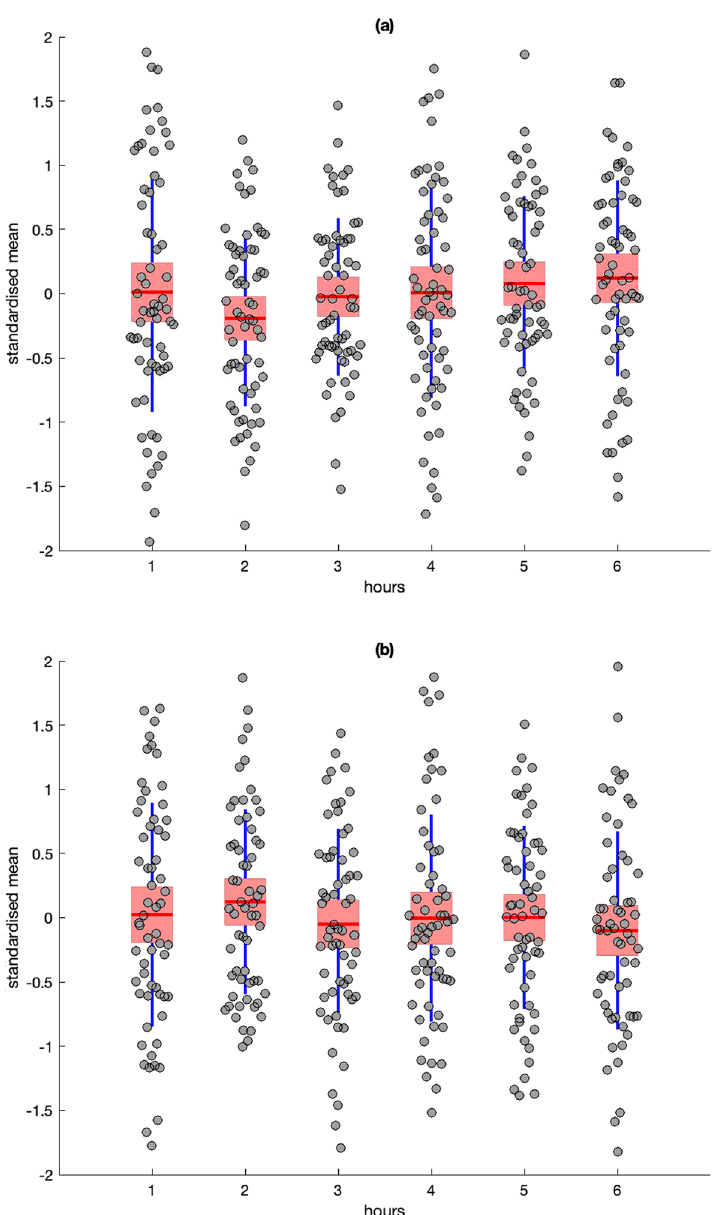
Figure 2. Descriptive statistics for standardised residuals for Heart Rate (HR) ( a ) and RMSSD ( b ). Red line = mean, pink box = standard deviation, blue lines = 95% confidence intervals, grey circles = raw